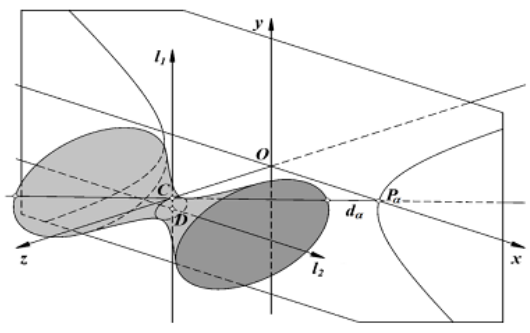
Figure 4: Scheme of the rotation of camera platform ( a ̸= 0